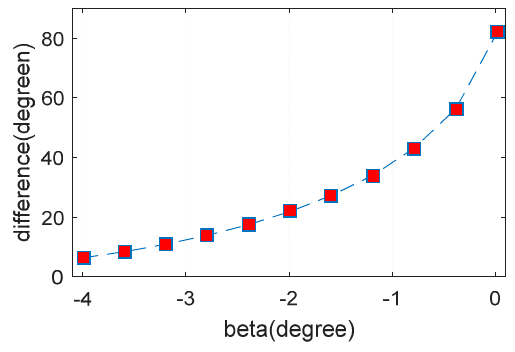
Figure 8. The yaw angle differences of E01 (FOC) during noon maneuver for different sun angles ( − 4.00° to 0.02°).